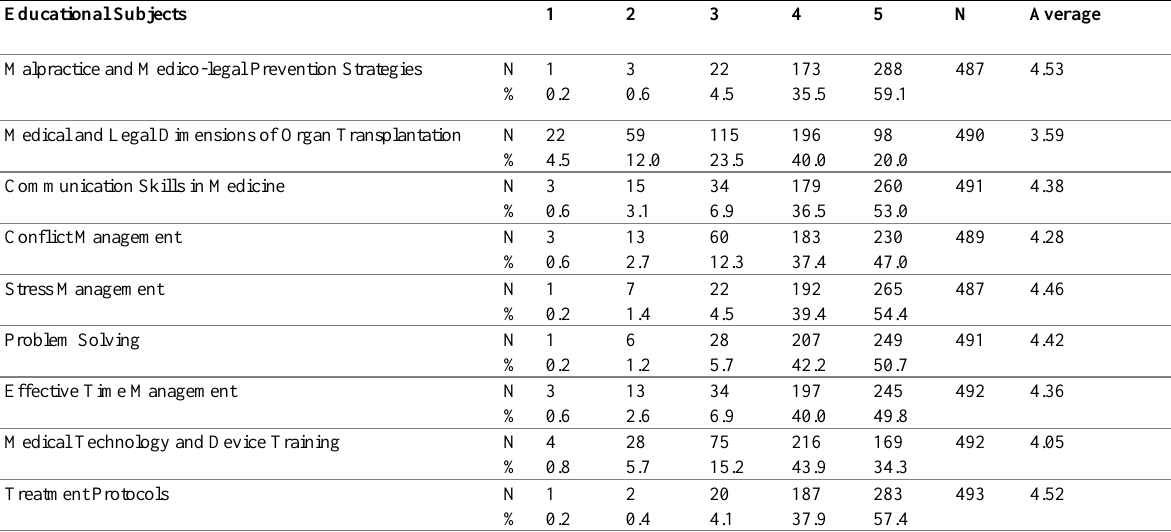
Table 24: Necessity of Personal Development for Family